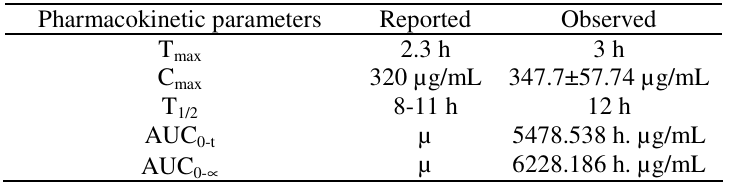
Figure 3. Valdecoxib concentration vs. time profile from three drug recipients Table 2. Pharmacokinetic